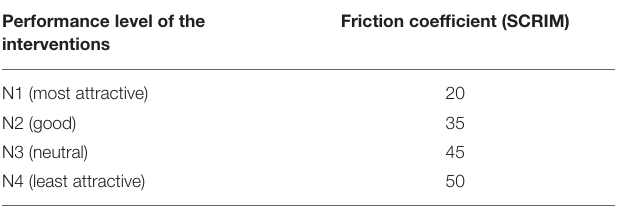
TABLE 3 | Performance scale of the interventions relative to friction coefficient. Performance level of the interventions